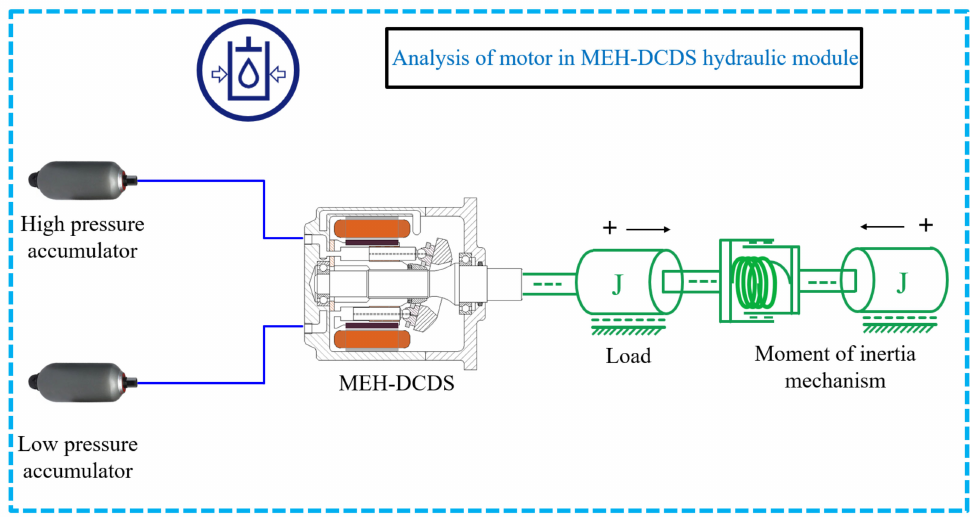
Figure 6. Analysis model diagram of the motor in MEH-DCDS hydraulic